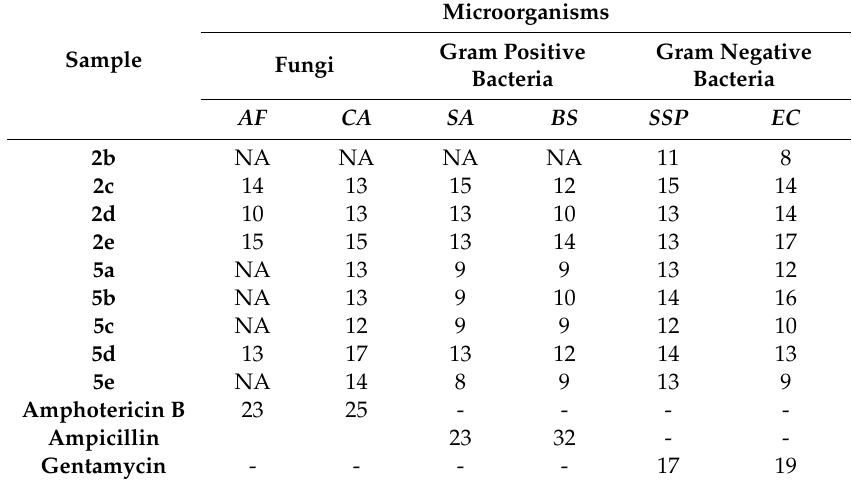
Table 4. The in vitro antimicrobial assessment of the synthesized compounds expressed as inhibition zones diameter in millimeters